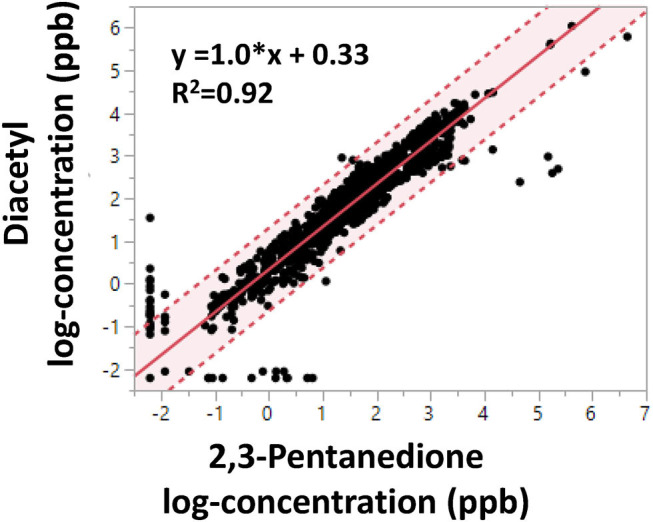
Linear regression of OSHA Methods 1013/1016 diacetyl and 2,3-pentanedione air concentrations (log-concentration in ppb). Shaded area indicates 95% confidence interval. Dotted lines represent 95% confidence limits.